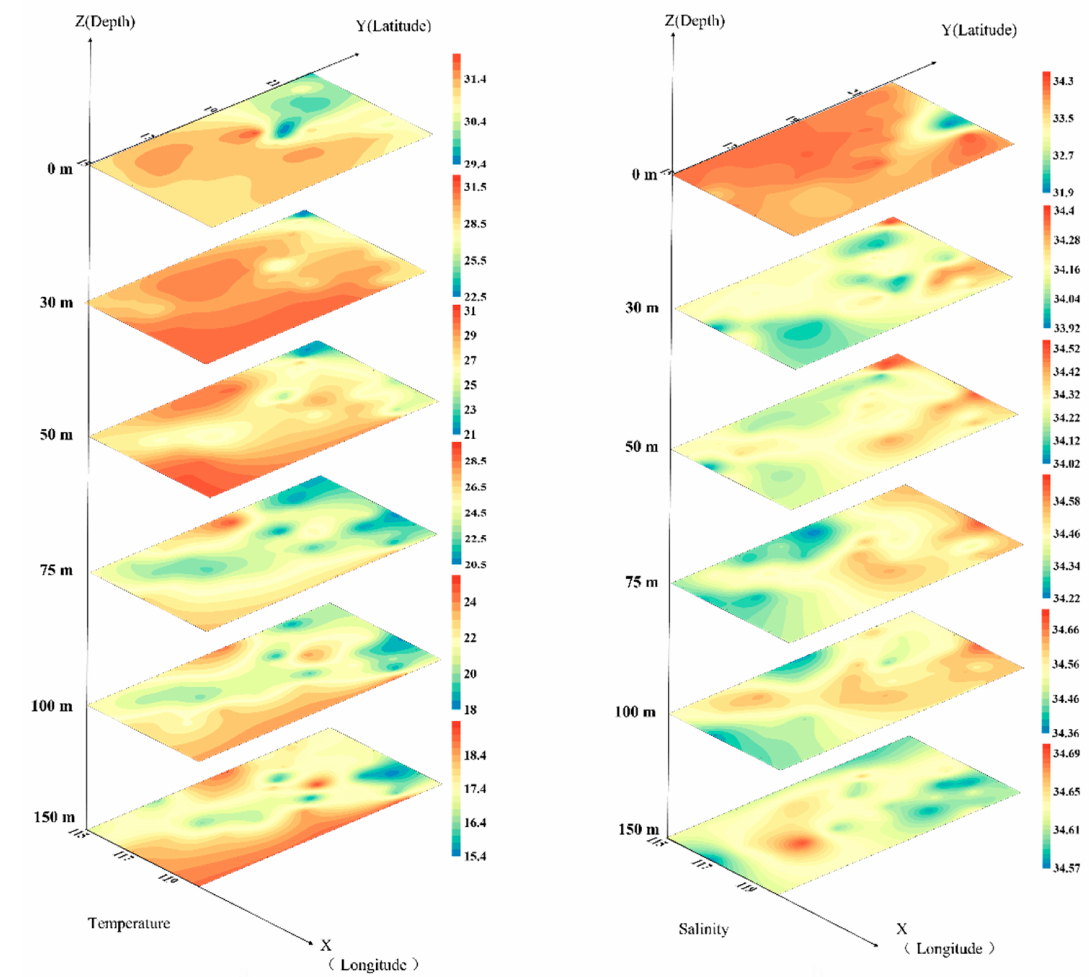
Figure 2. The temperature and salinity in the six water layers at sampling stations in the northern South China